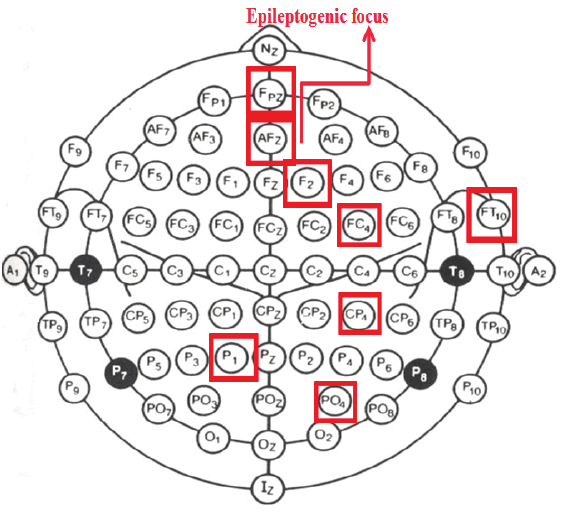
Figure 1. Positions of electrodes on the scalp surface according to 10-10 system. The electrodes of whose the measurements where used in this study are shown in rectangular frames. The label “Epileptogenic focus” indicates the area of the epileptogenic